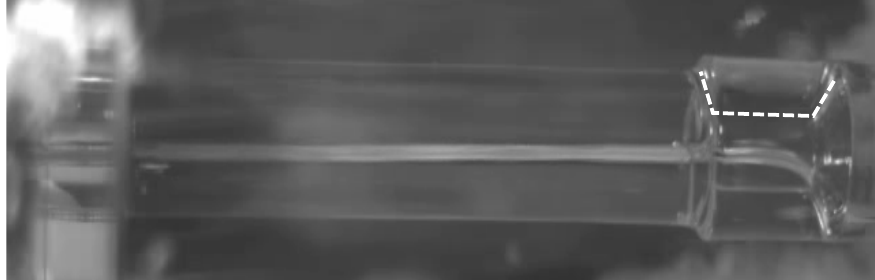
11 of 17 Figure 10. DPS and DPT vs. time. The differential pressure DPST, DPS, and DPT are stable until 15:51:42, and a smooth stratified flow occurs in the vicinity of the orifice (Figure 11). DPT and DPST fluctuated slightly from 15:51:42 until 16:00:07, when stratified wavy flow occurs, and one of these